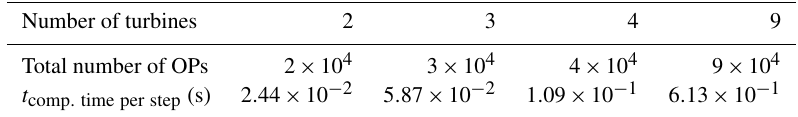
Table 3. Computational